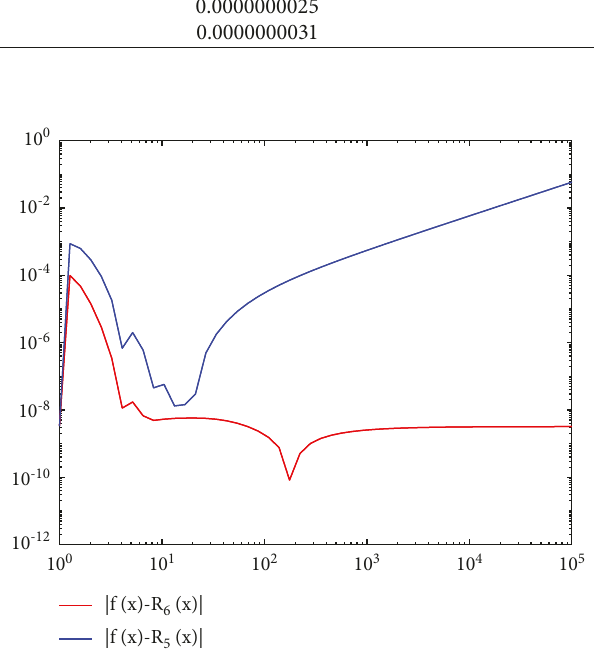
Figure 2: Function plots of | f ( x ) − R